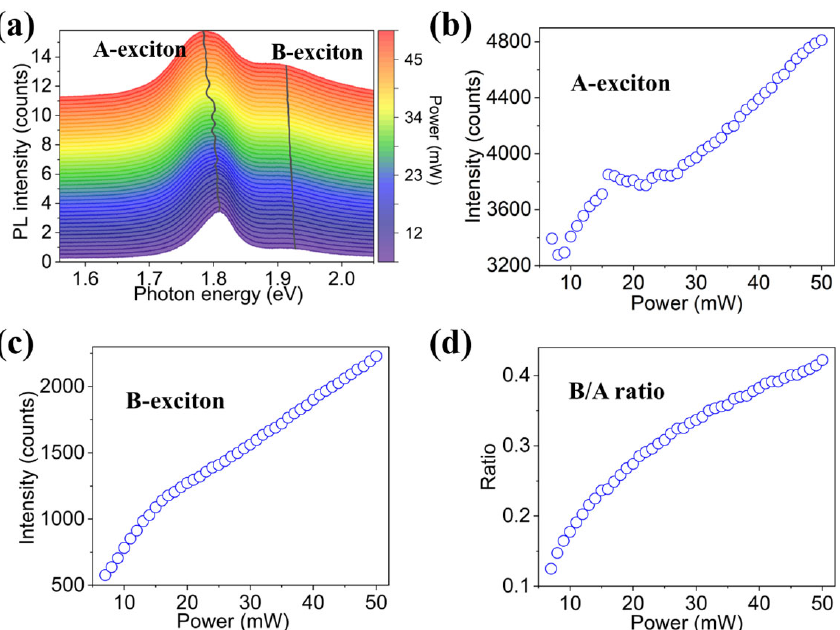
Figure 3. ( a ) The PL spectra of the monolayer MoS 2 pumped by laser with high power ranging from 5 to 50 mW. ( b – d ) The power ‐ dependent ( b ) intensity of A ‐ exciton, ( c ) intensity of B ‐ exciton, and ( d ) intensity ratio of B/A.